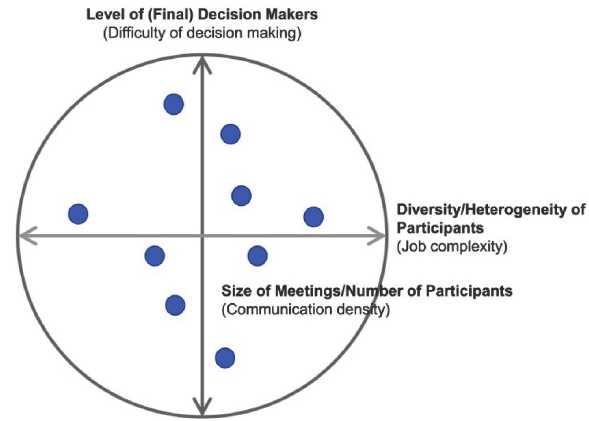
Figure 1. Major organizational factors affecting decision- making efficiency